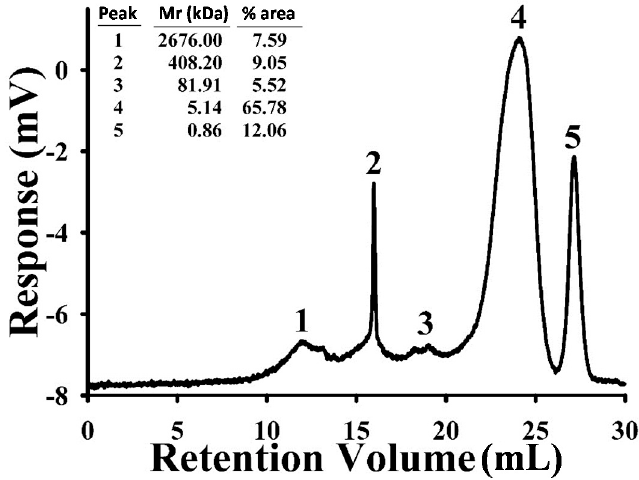
Figure 1. The composition of Astragalus membranaceus Polysaccharides (APS). Carbohydrate solution was injected onto the Size-Exclusion Chromatography (SEC) column and was eluted by deionized water. SEC signal detection (response, mV) was performed using a ViscoTek model TDA-3-1 relative viscometer (Viscotek, Houston, TX, USA). Sodex P-82 series (Showa Denko America, New York, NY, USA) containing polymaltotriose with molecular weights of 78.8 × 10 4 , 40.4 × 10 4 , 21.2 × 10 4 , 4.73 × 10 4 , and 1.18 × 10 4 Daltons (Da) was used as authentic standard. The molecular weight (Mr (kDa)) and area percentage (% area) of each peak was calculated and displayed at upper left corner.